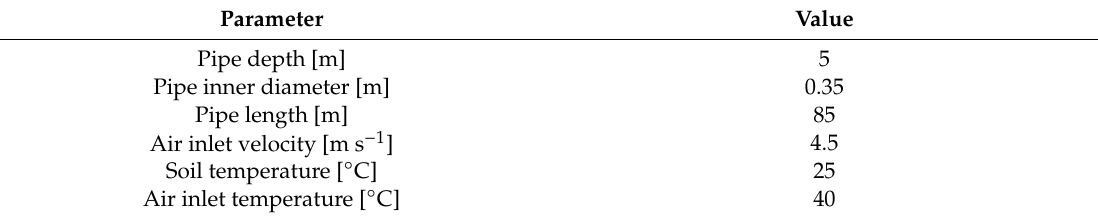
Table 5. Boundary conditions of model validation 2